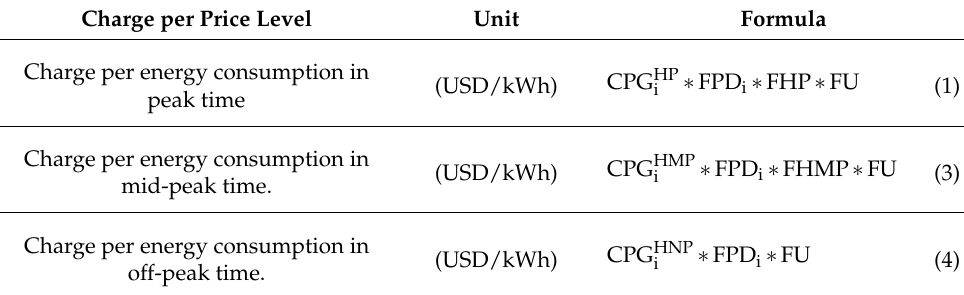
Table 6. Tariff formulas for commercial TOUP